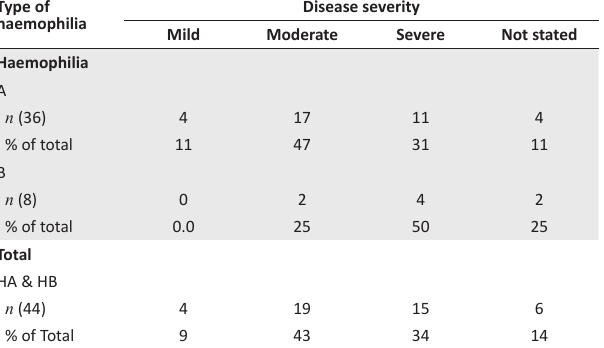
TABLE 2: Haemophilia versus disease severity by factor assay